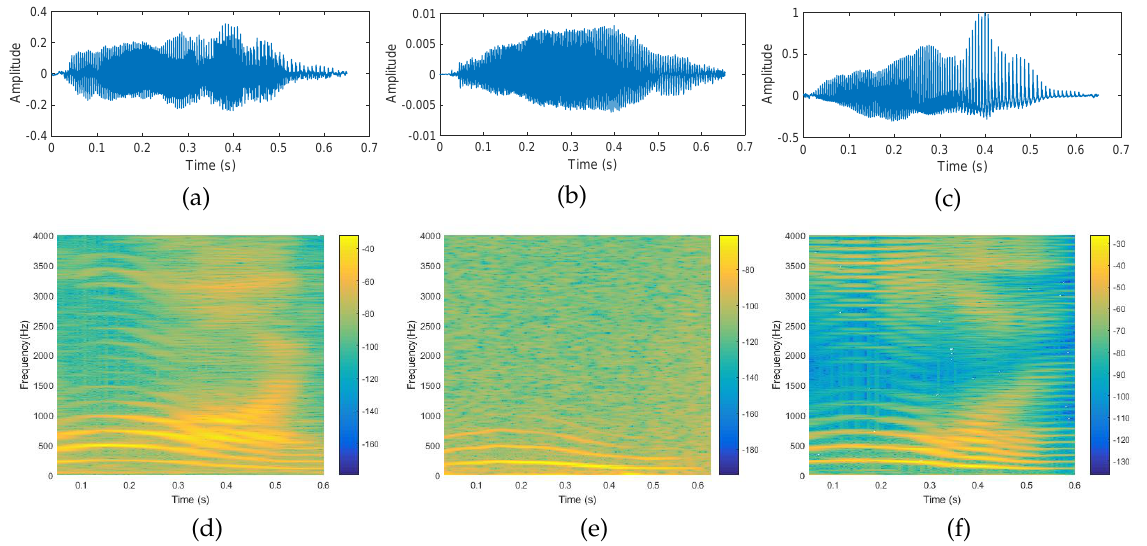
Figure 11. Speech recovery results for the English word “boy”. ( a ) Waveform of the original speech signal; ( b ) waveform of the radar signal; ( c ) waveform of the synthesized speech signal; ( d ) spectrogram of the original speech signal; ( e ) spectrogram of the radar signal; ( f ) spectrogram of the synthesized speech signal.